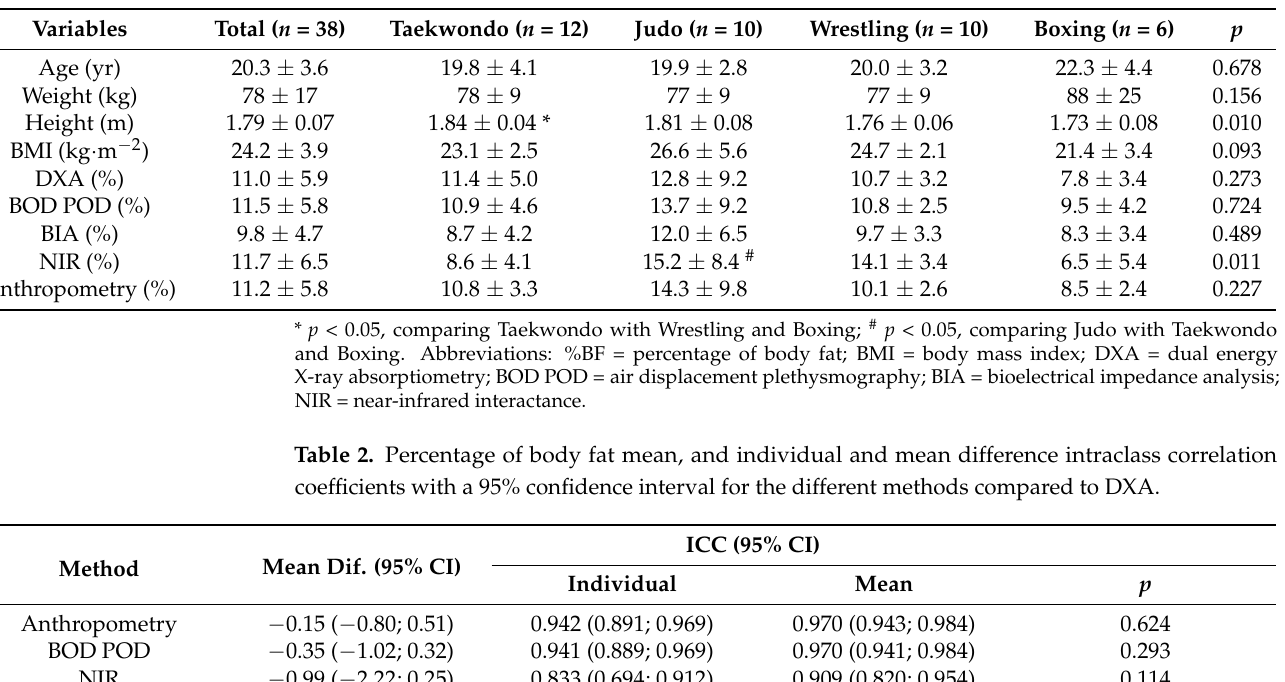
Table 1. Descriptive analysis and p -values for combat sports athletes’ %BF—total and by sport— measured using laboratory and field methods.